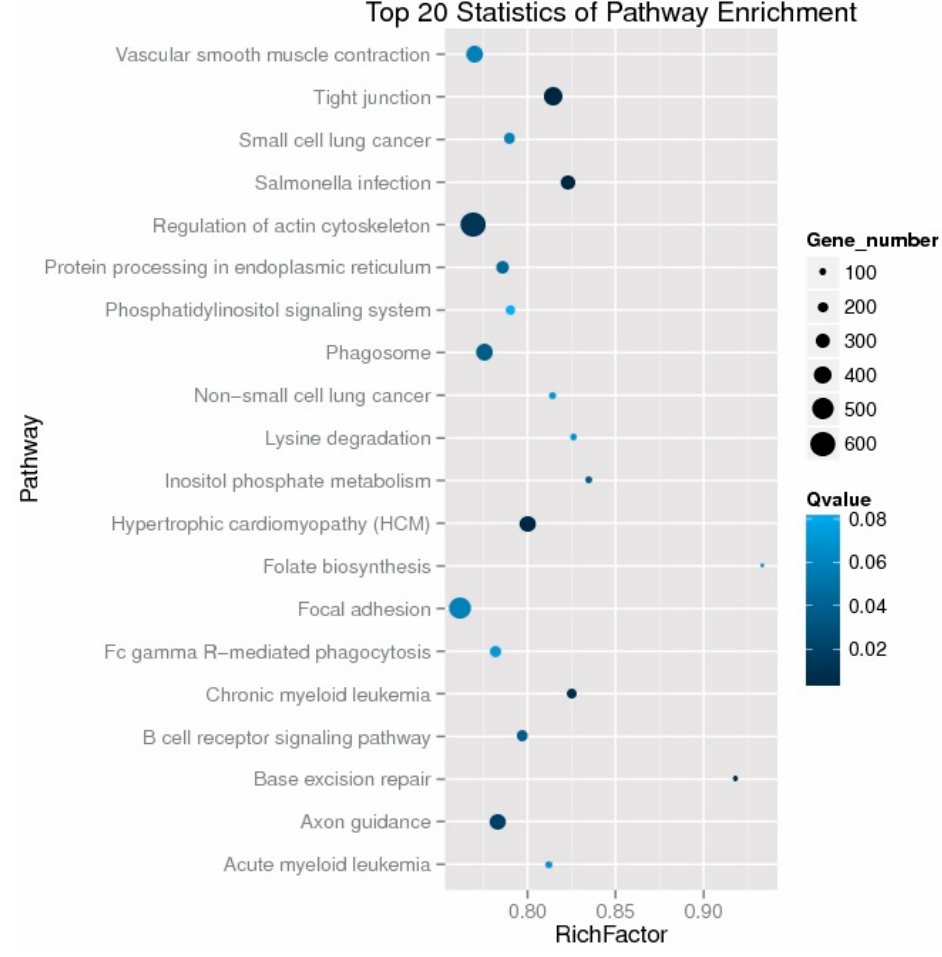
Figure 3. The top 20 KEGG pathways enriched for targets of the 14 differentially ‐ expressed miRNAs.